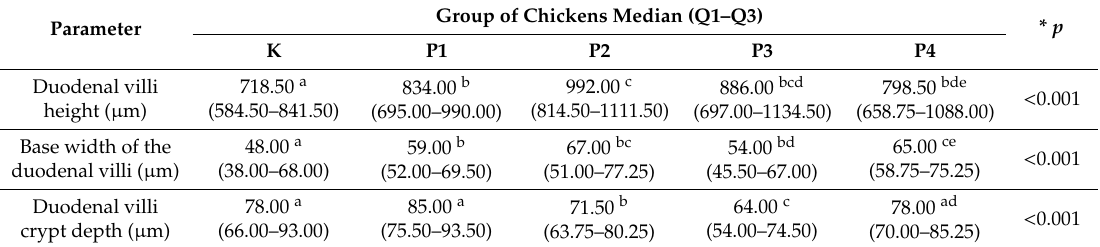
Table 3. The values of evaluated parameters of duodenal villi of broiler chickens on the 42nd day of the feeding trial.